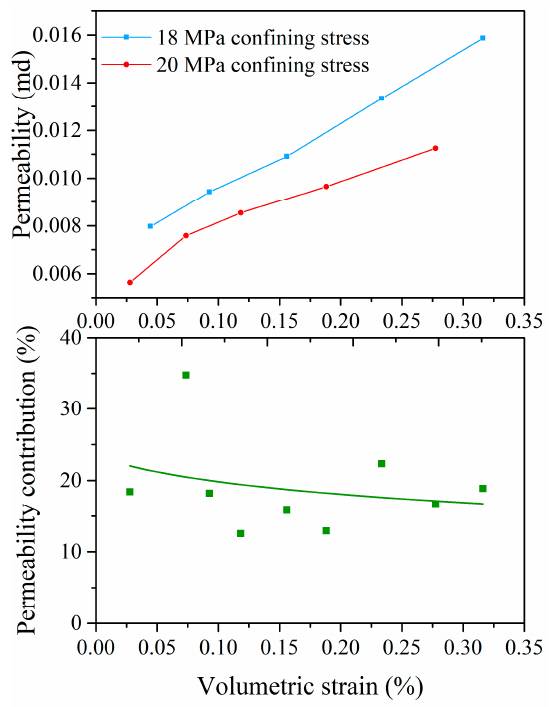
Figure 15. Sup-critical CO 2 permeability and permeability contribution versus the volumetric strain.